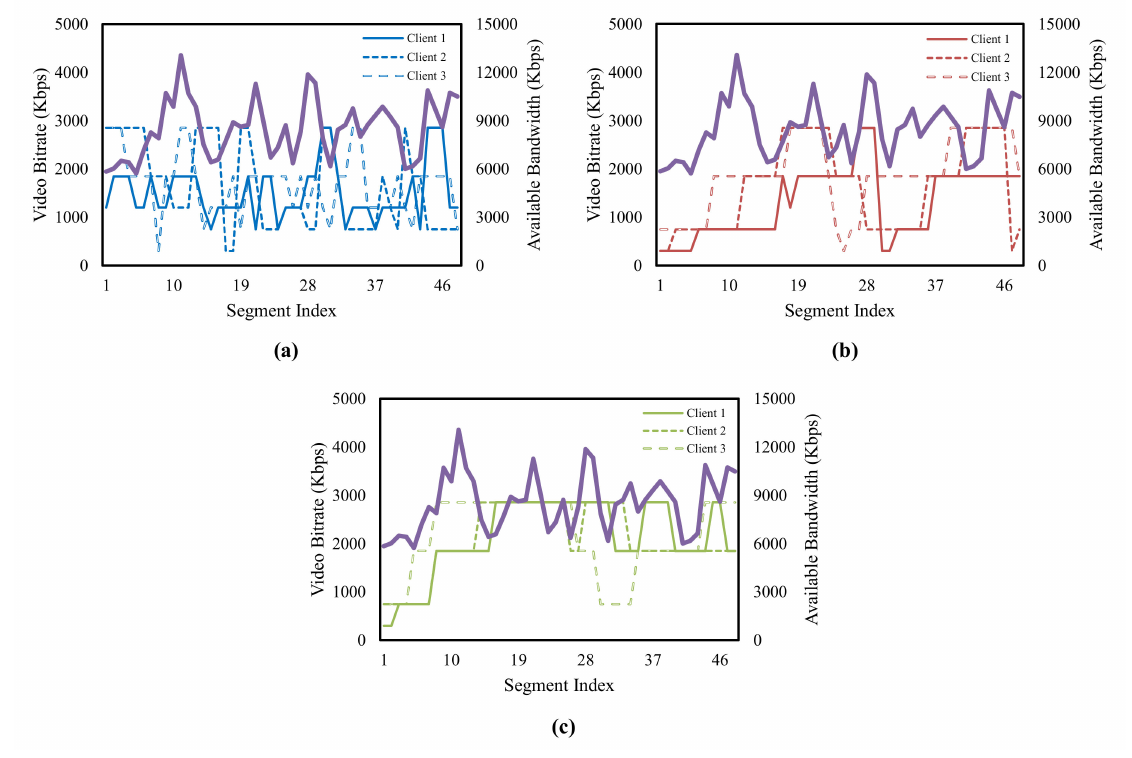
Figure 10. Comparisons of the bitrate changes of each scheme, ( a ) ECAA, ( b ) Pensieve, ( c )